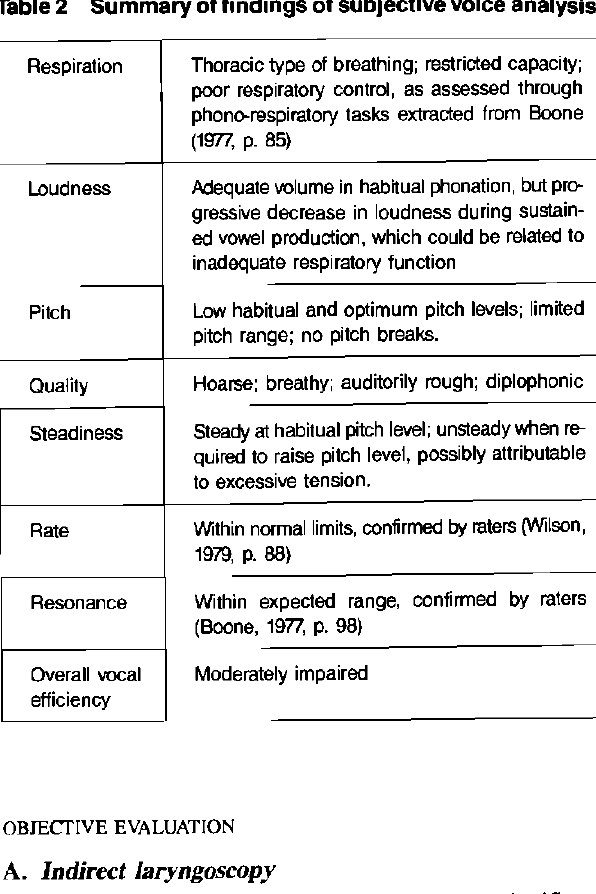
Table 2 Summary of findings of subjective voice analysis